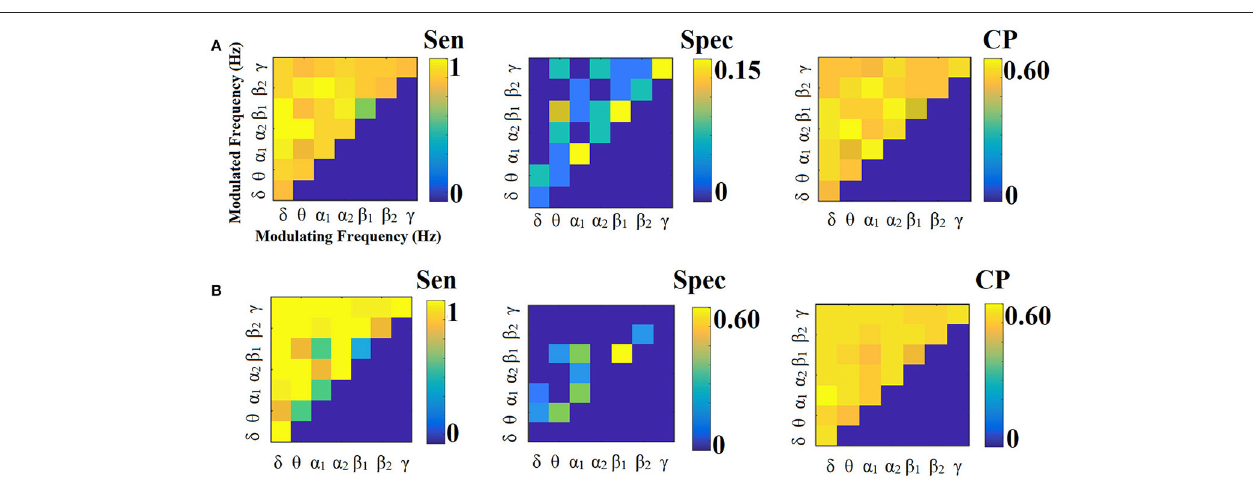
FIGURE 9 | Sensitivity, specificity and classification performance of CorrEnv using PCA ROI representation and tensorial treatment of each SL-FCG. (A) Sensitivity, specificity and classification performance for the LOOCV and (B) Sensitivity, specificity and classification performance for the 5-fold CV. Sen, sensitivity; Spec, specificity; CP, classification